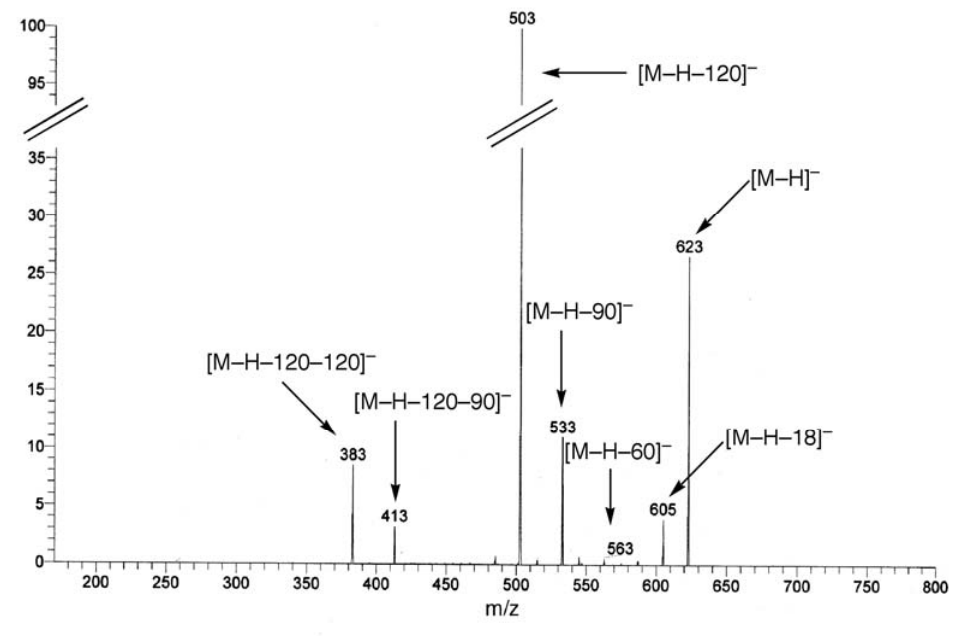
Figure 7 . Negative mode MS-MS spectrum (focused on the pseudomolecular ion) of diosmetin 6,8-di- C -glucoside ( 32